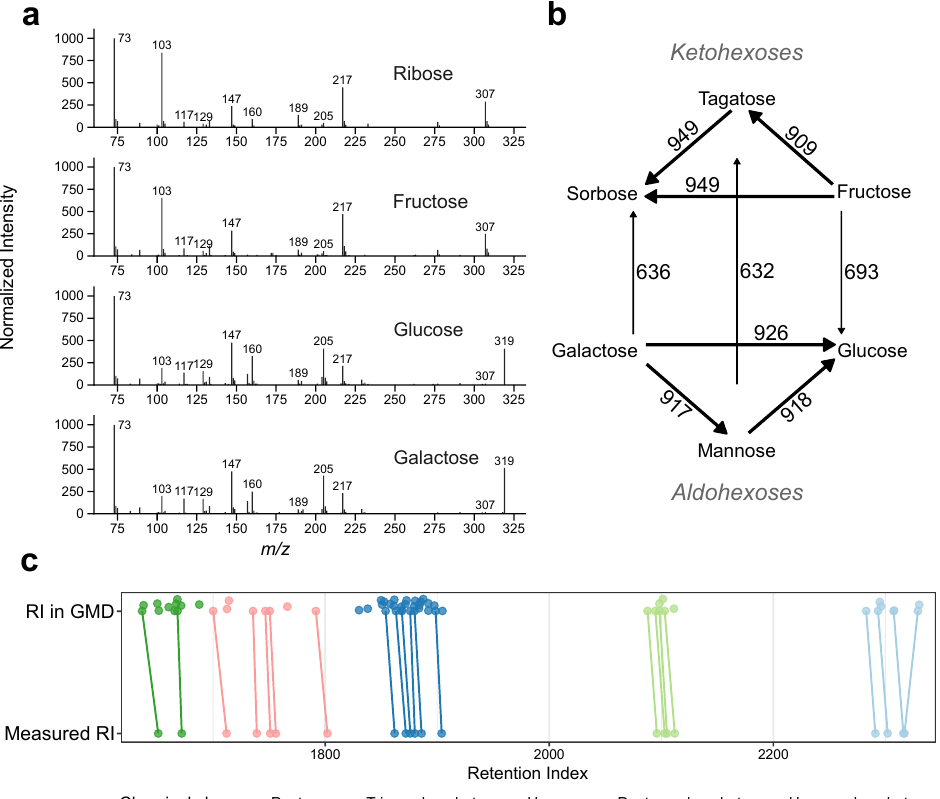
Figure 3. Mass spectra- and retention time similarities between sugars in measured by GC–MS. ( a ) Electron impact mass spectra of ribose (an aldopentose), fructose (a ketohexose), glucose and galactose (aldohexoses), note their similarity. ( b ) RMF-values between GMD spectra; ketohexoses (top) and aldohexoses (bottom). Arrows indicate direction of comparison ( c ) Retention indices as stored in the GMD (top) and measured on our system (bottom). Colours indicate groups of sugars, thus inherently similar compounds. Compounds detected in both setups are connected by lines to show the shifts between the systems. Note, that the shifts are not always identical and span over several other compounds in the GMD with similar mass